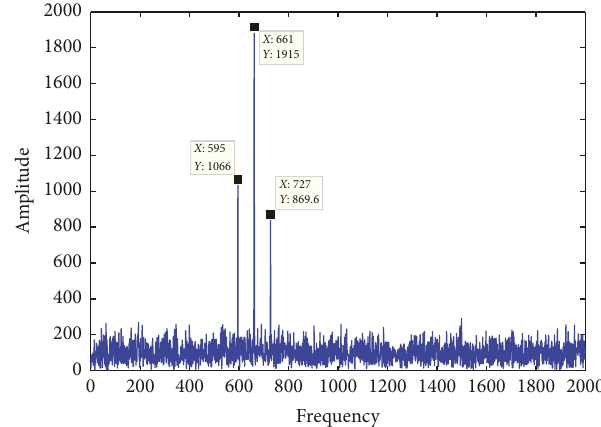
Figure 6: The LCT of the simulated gear vibration signal with